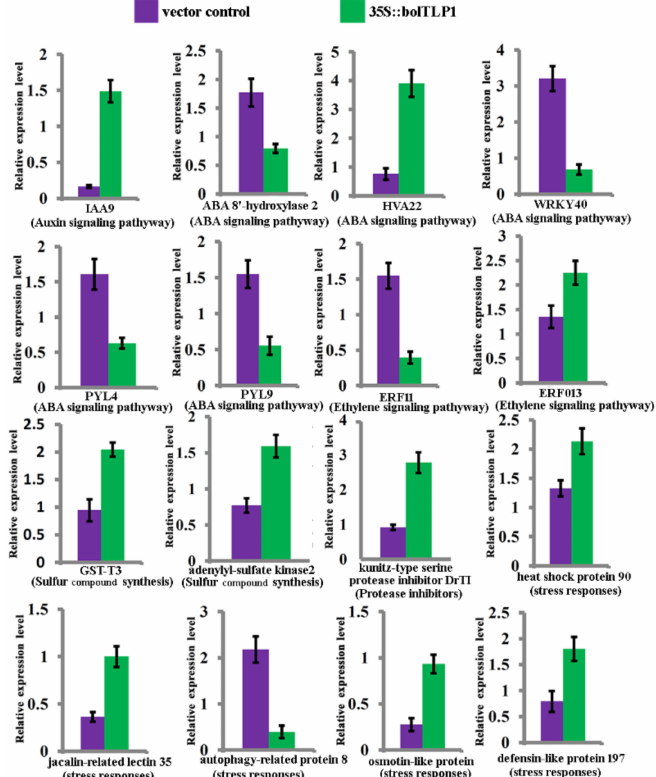
Figure 7. Identification of the relative expression levels of the representative genes by qRT-PCR. GST: glutathione S-transferase. PYL: abscisic acid receptor PYR/PYL/RCAR. ERF: ethylene-responsive transcription factor. IAA9: indol-yl-3-acetic acid 9. RD22: dehydration-responsive protein 22. 35S::bolTLP1: 35S:: bolTLP1 broccoli. Vector control: vector control